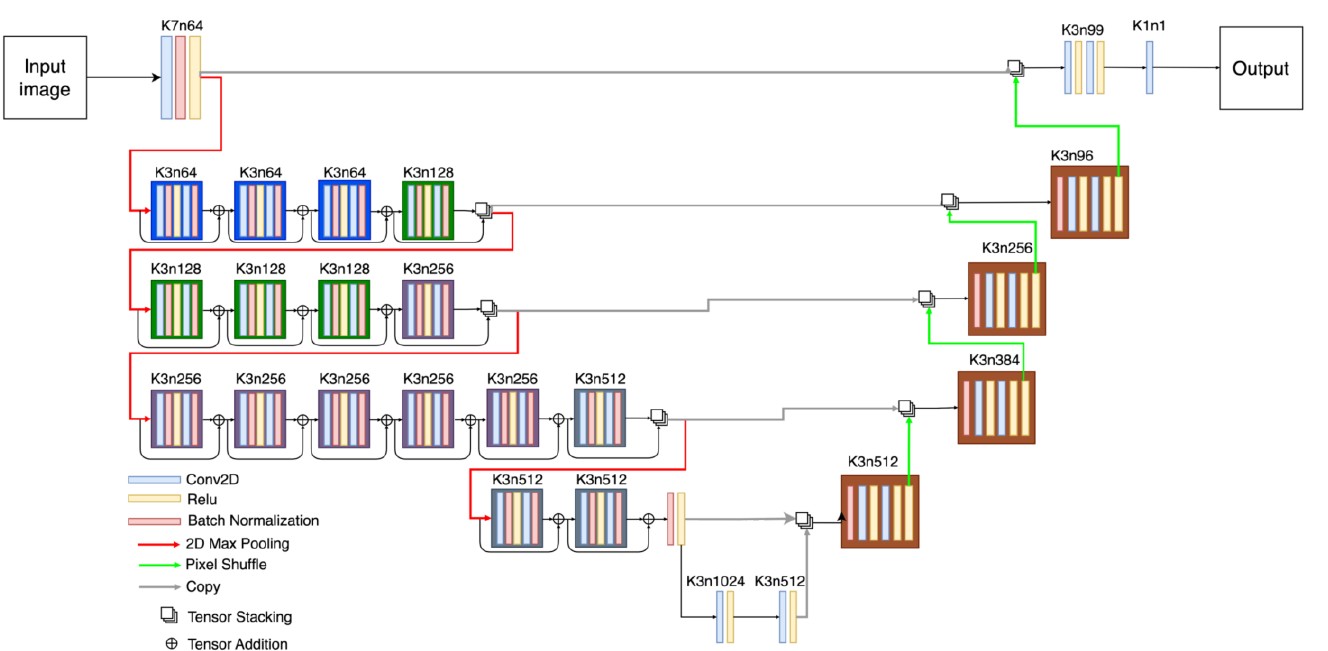
Figure 2. Dense UNet (DUNet) architecture. Orange rectangles represent the newly calculated fea- ture maps at every level. Blue rectangles are the feature maps that are dropped during the expansion path and green rectangles are the feature maps that are copied during the expansion path.